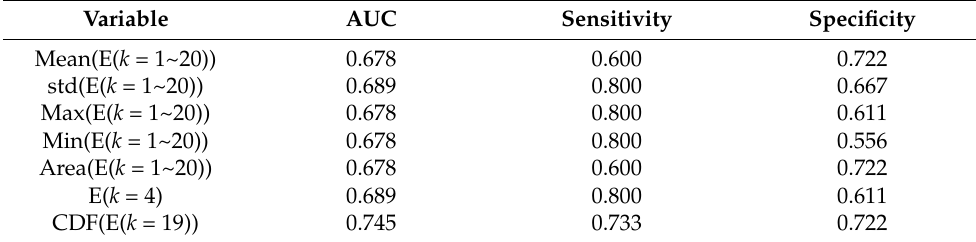
Figure 5. Distribution of AUC of E( k ) of iPR ( left ), and CDF(E( k )) of iPR ( right ). For comparison with conventional PRV time series, Table 3 showed the AUC of the above variables calculated by using the PPi series. The AUC of all variables related to the entropy value of the PPi series was lower than the CDF(E( k = 19)) of the iPR. Table 3. The AUC of the variables related to the entropy value of